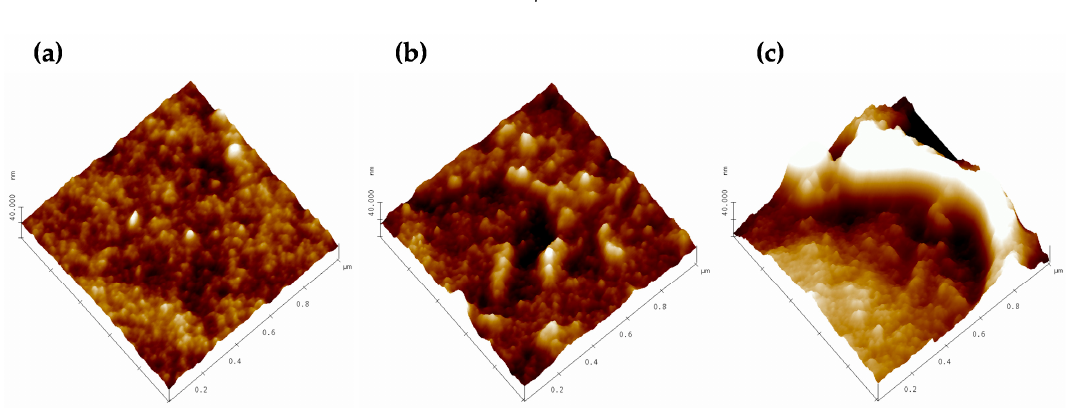
× 1 µ m images of: ( a ) HFM-183, (b ) HFM-183 + PSS, and ( c ) HFM-183 + PSS + Figure 1. Topographic 1 × 1 μ m images of: ( a ) HFM-183, (b ) HFM-183+PSS, and ( c ) HFM-183+PSS+Ar. Figure 1. Topographic 1